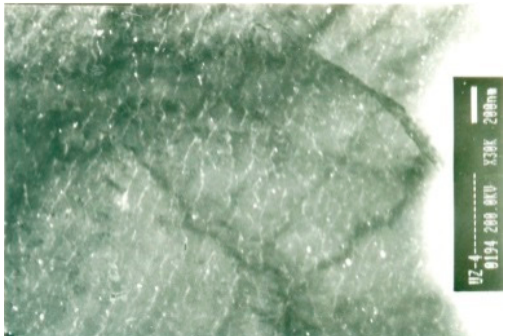
Figure 5. TEM micrograph showing the onset of strain-induced precipitation at 963 °C, low temperature (LT) variant.